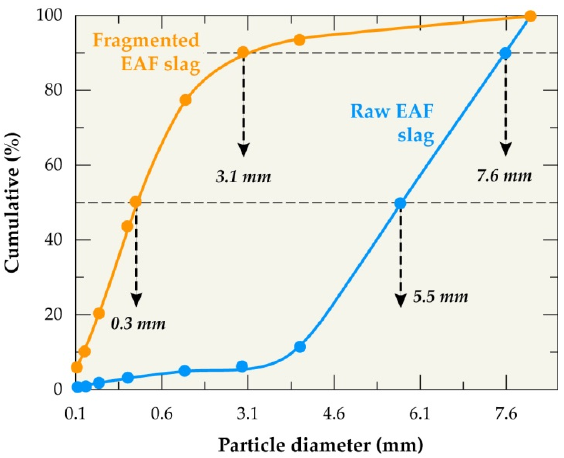
Figure 2. Particle size distribution of raw EAF slag and electro ‐ fragmented EAF slag.